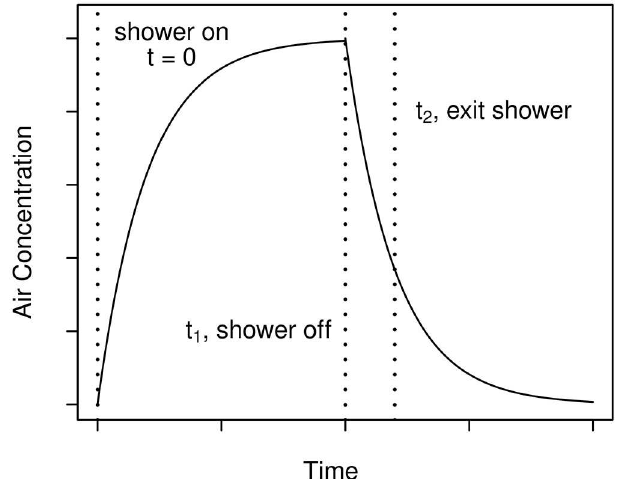
Fig 5. Behavior of contaminant concentration in air in a shower